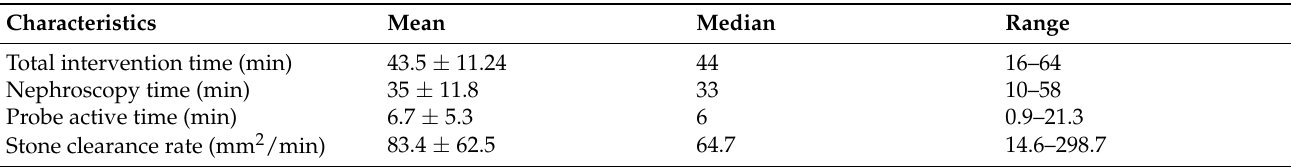
Table 2. Intervention times and clearance rates in the Trilogy group.